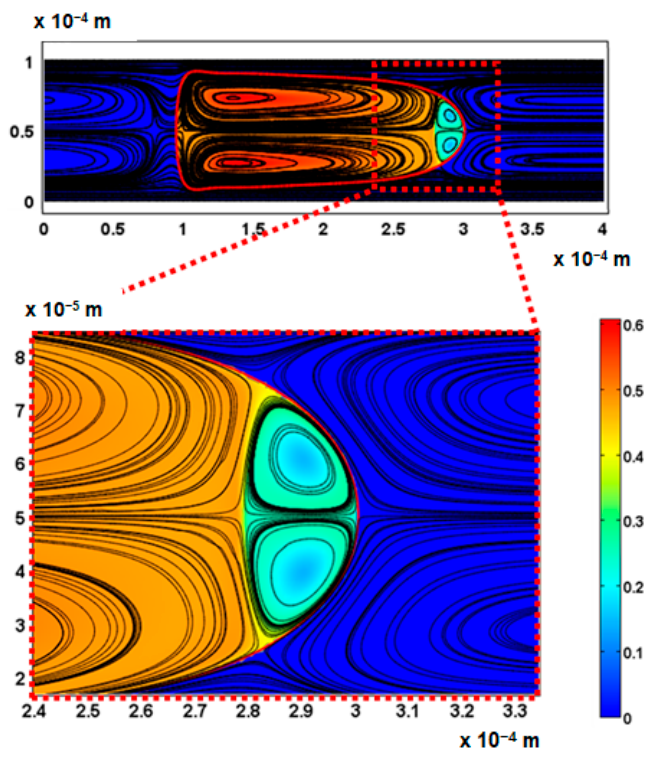
Figure 24. Influence of stagnation zones on poor mixing at the nose of the plug. The colour scale represents concentration (mol/m 3 ).